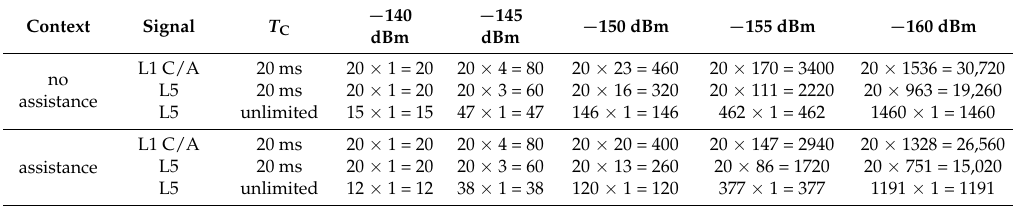
Table 5. Total integration time T IT = T C × N NC as function of the sensitivity and context with GPS signals, for average losses. Note that the sensitivities given are for the L1 C/A signal; those of L5 are 1.5 dB higher.